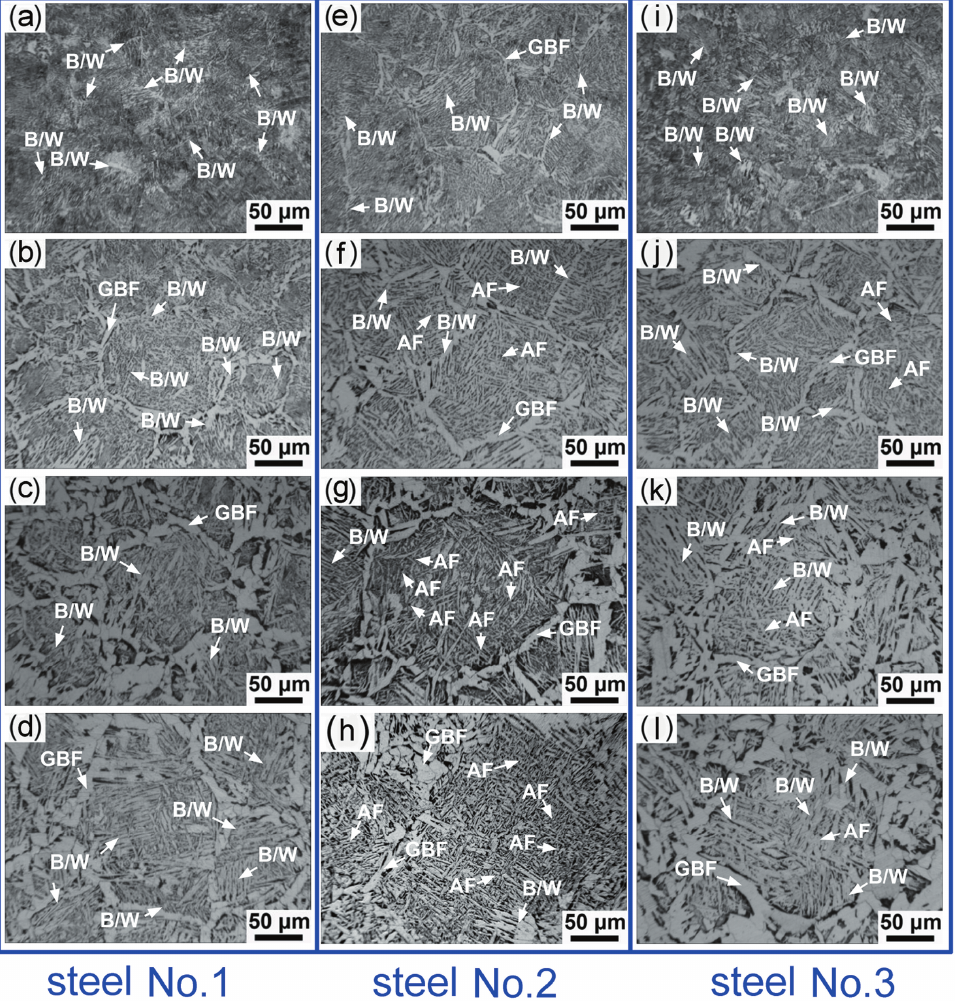
Figure 3: Effect of t 8/5 on the variation of microstructure in the heat affected zone of three steels, (a, e and i) t 8/5 = 28s; (b, f and j) t 8/5 = 111s; (c, g and k) t 8/5 = 250s; (d, h and l) t 8/5 =